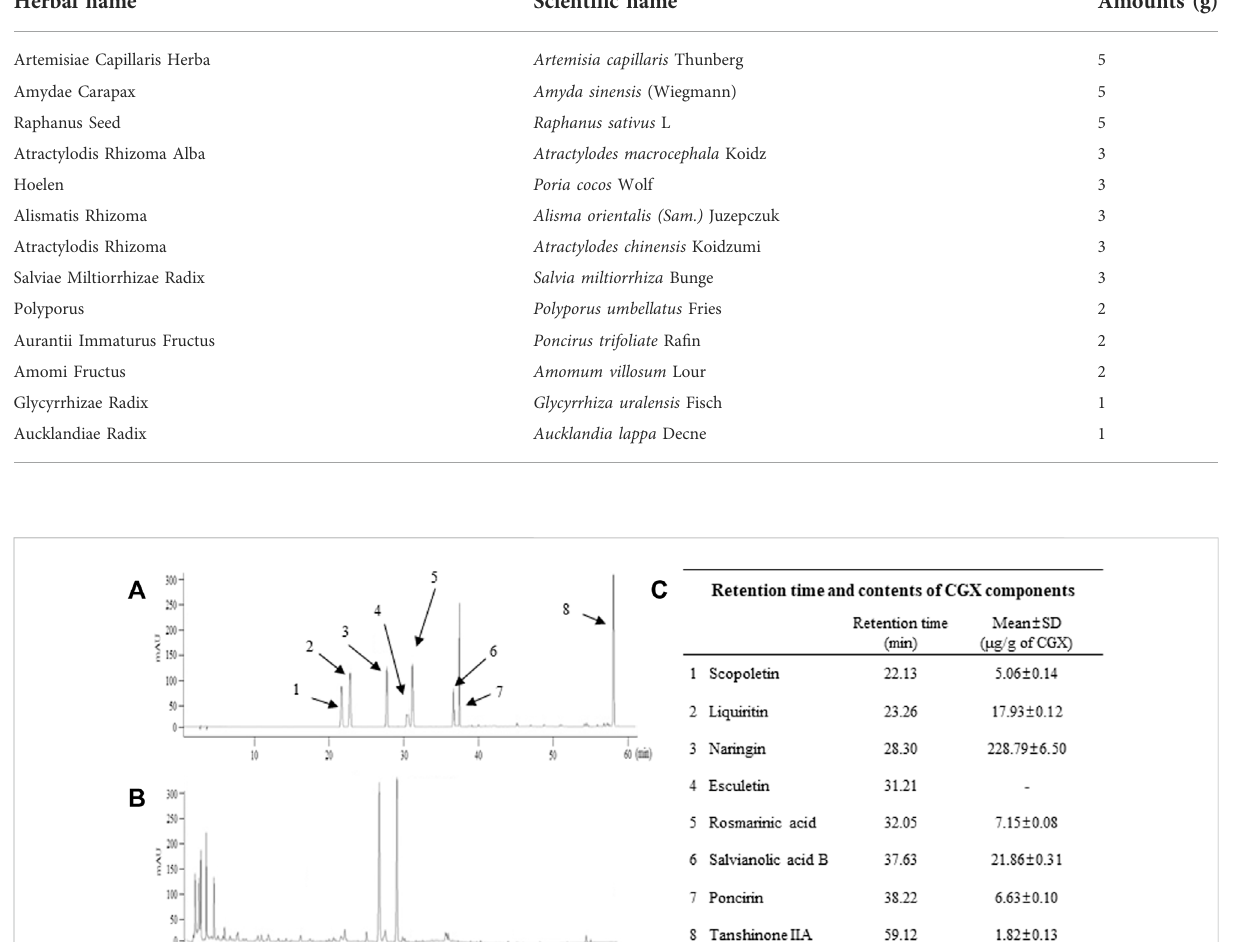
TABLE 1 Components of CGX.